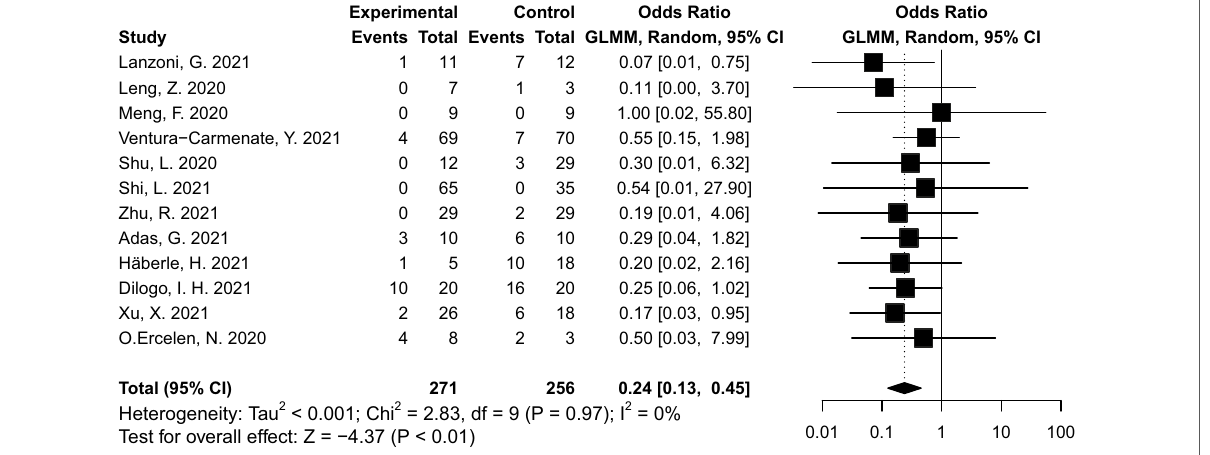
Fig. 4 Forest plot of mortality: odds ratio (95% CI) and pooled estimates